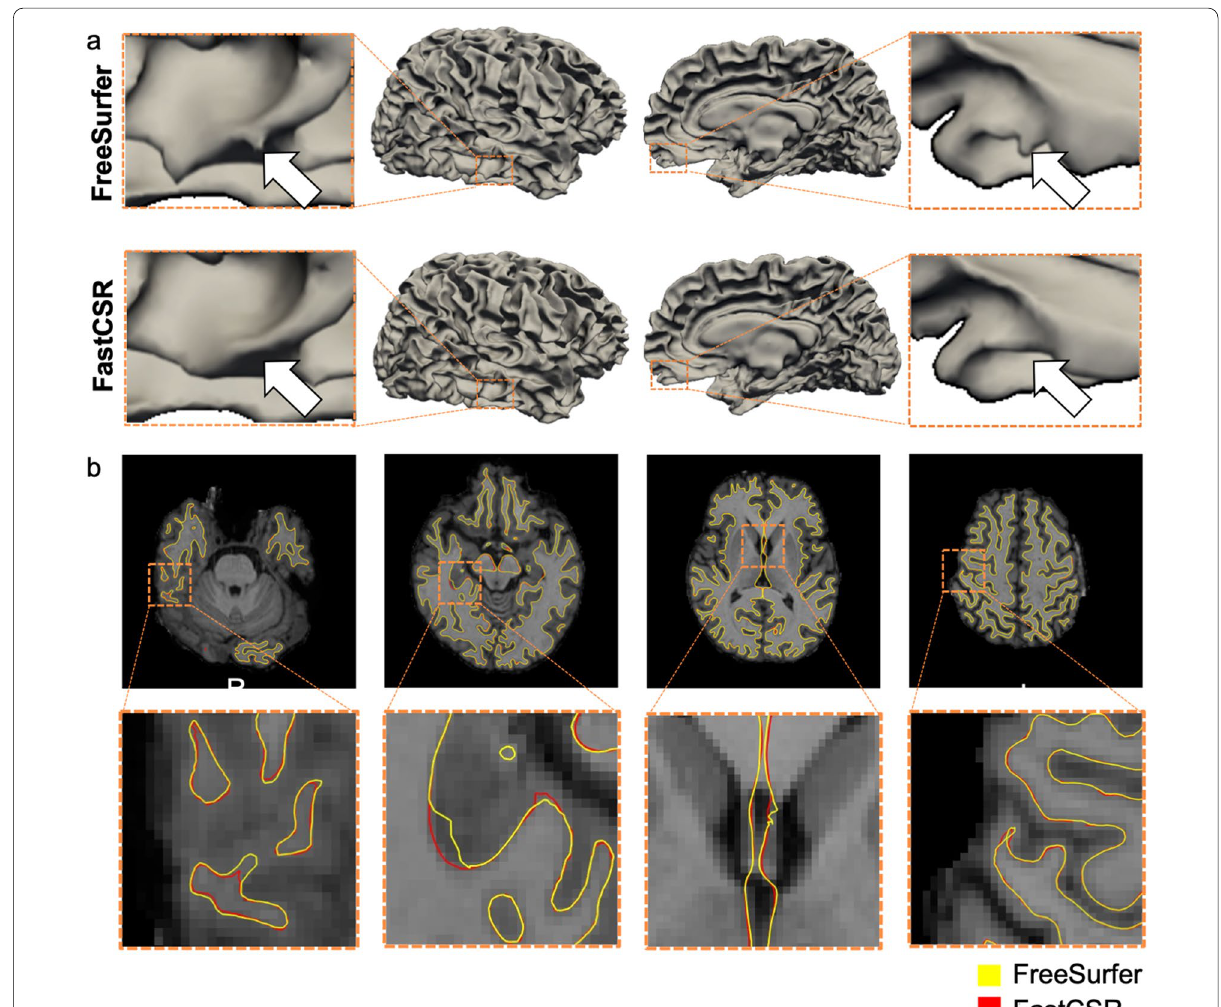
Fig. 3 Surfaces reconstructed by FastCSR are comparable to results from FreeSurfer. a The cortical surfaces from a randomly selected healthy participant reconstructed using the FreeSurfer (the upper panel) and the FastCSR (the lower panel) pipelines. The surfaces generated by different methods show high similarity with small discrepancies that are highlighted by orange dashed boxes. b Horizontal slices at multiple levels taken from the participant’s T1w image showing the cortical surface identified using FreeSurfer (yellow lines) and FastCSR (red lines) show that both methods accurately capture the boundary between white and gray matter. The surfaces derived from these two methods showed a high degree of overlap in most of cortical areas, indicating high concordance between these two methods. Small discrepancies are highlighted by orange dashed